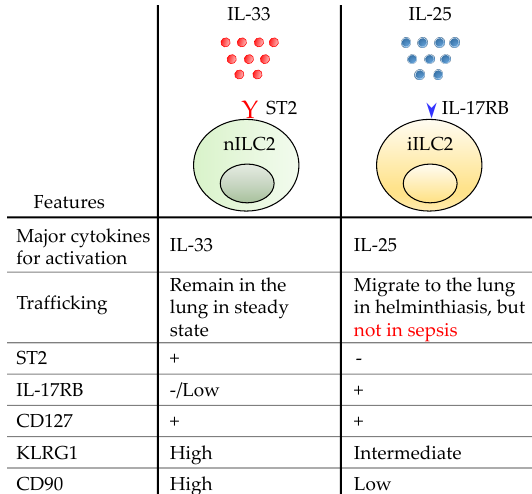
Figure 1. Representative features of natural group two innate lymphoid cell (nILC2) and inflammatory ILC2 (iILC2). nILC2 expresses ST2 (red Y), a receptor of IL-33. iILC2 expresses IL-17RB (blue arrowhead), a receptor of